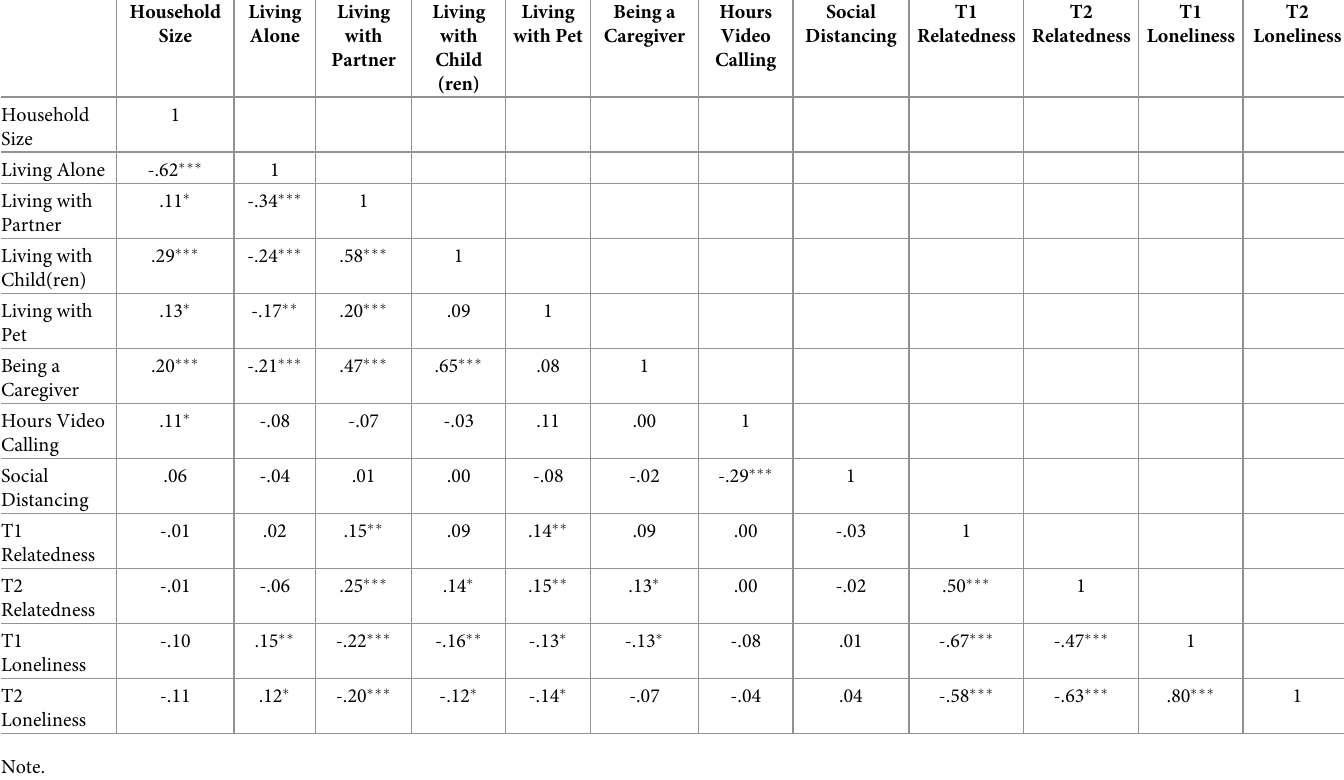
Table 4. Correlations among variables (Study